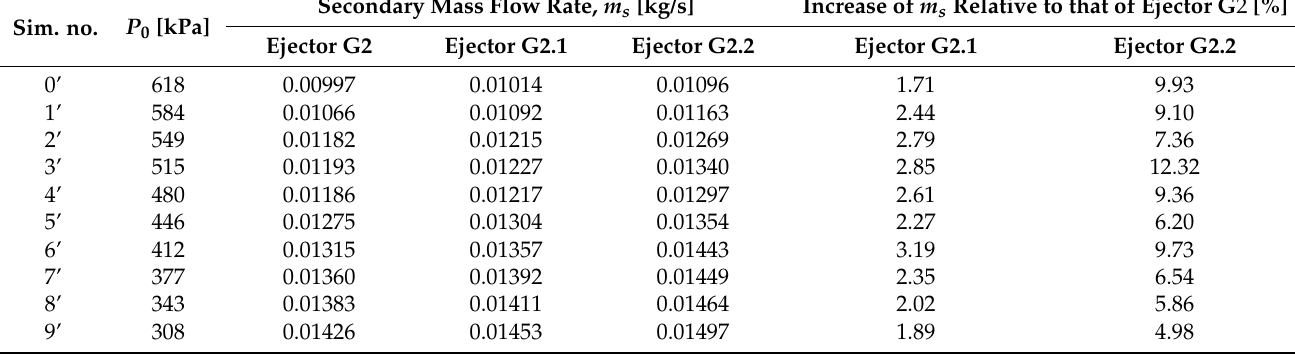
Table 6. Comparison of secondary mass flow rates from CFD simulation for ejectors having different inlet radius/converging angle of the converging mixing section. Sim.